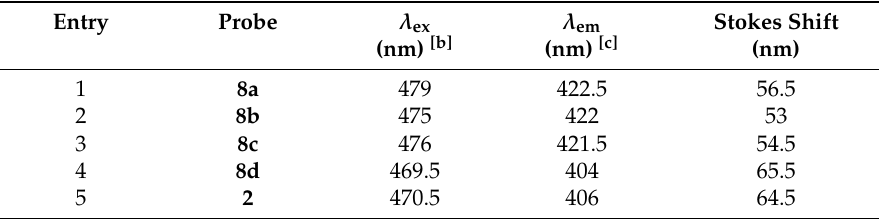
Table 1. Photophysical data for probes 8a – d and 2 [a] .